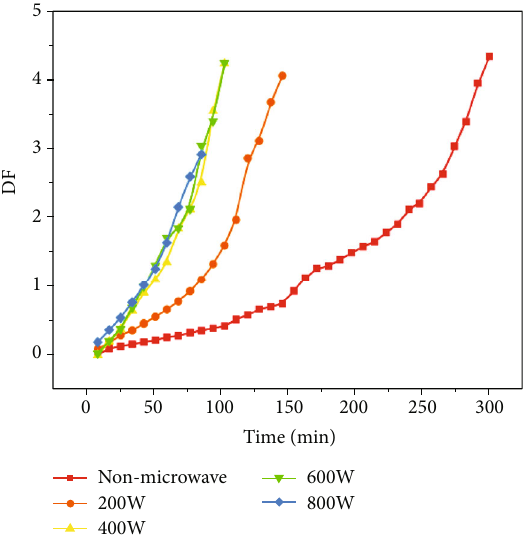
Figure 4: Drying rate of microneedle materials in di ff erent